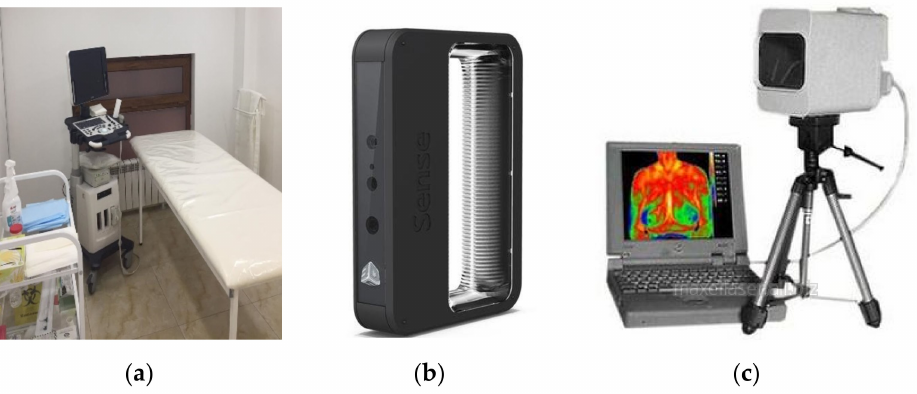
Figure 2. Clinical office for collecting patient data ( a ), the 3D Scanner Sense 2 ( b ), and IR camera IRTIS-2000 ME ( c